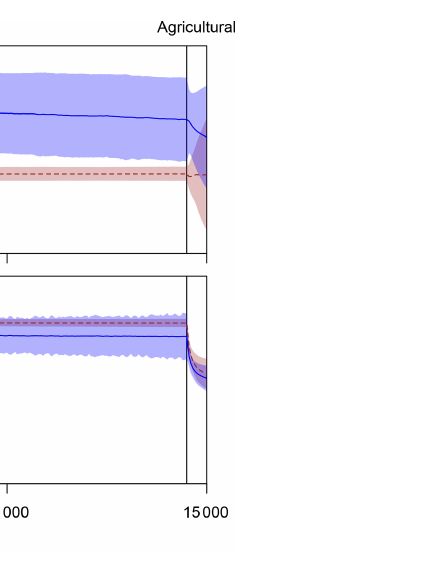
Figure 3. Evolution of the depth to Bt horizons (a) and the SOM stocks (b) in the simulations with HydroLorica. The line indicates the average (SLDS), and the polygon indicates the standard deviation (complexity) of the property. The vertical line at year 14500 indicates the start of the agricultural phase.